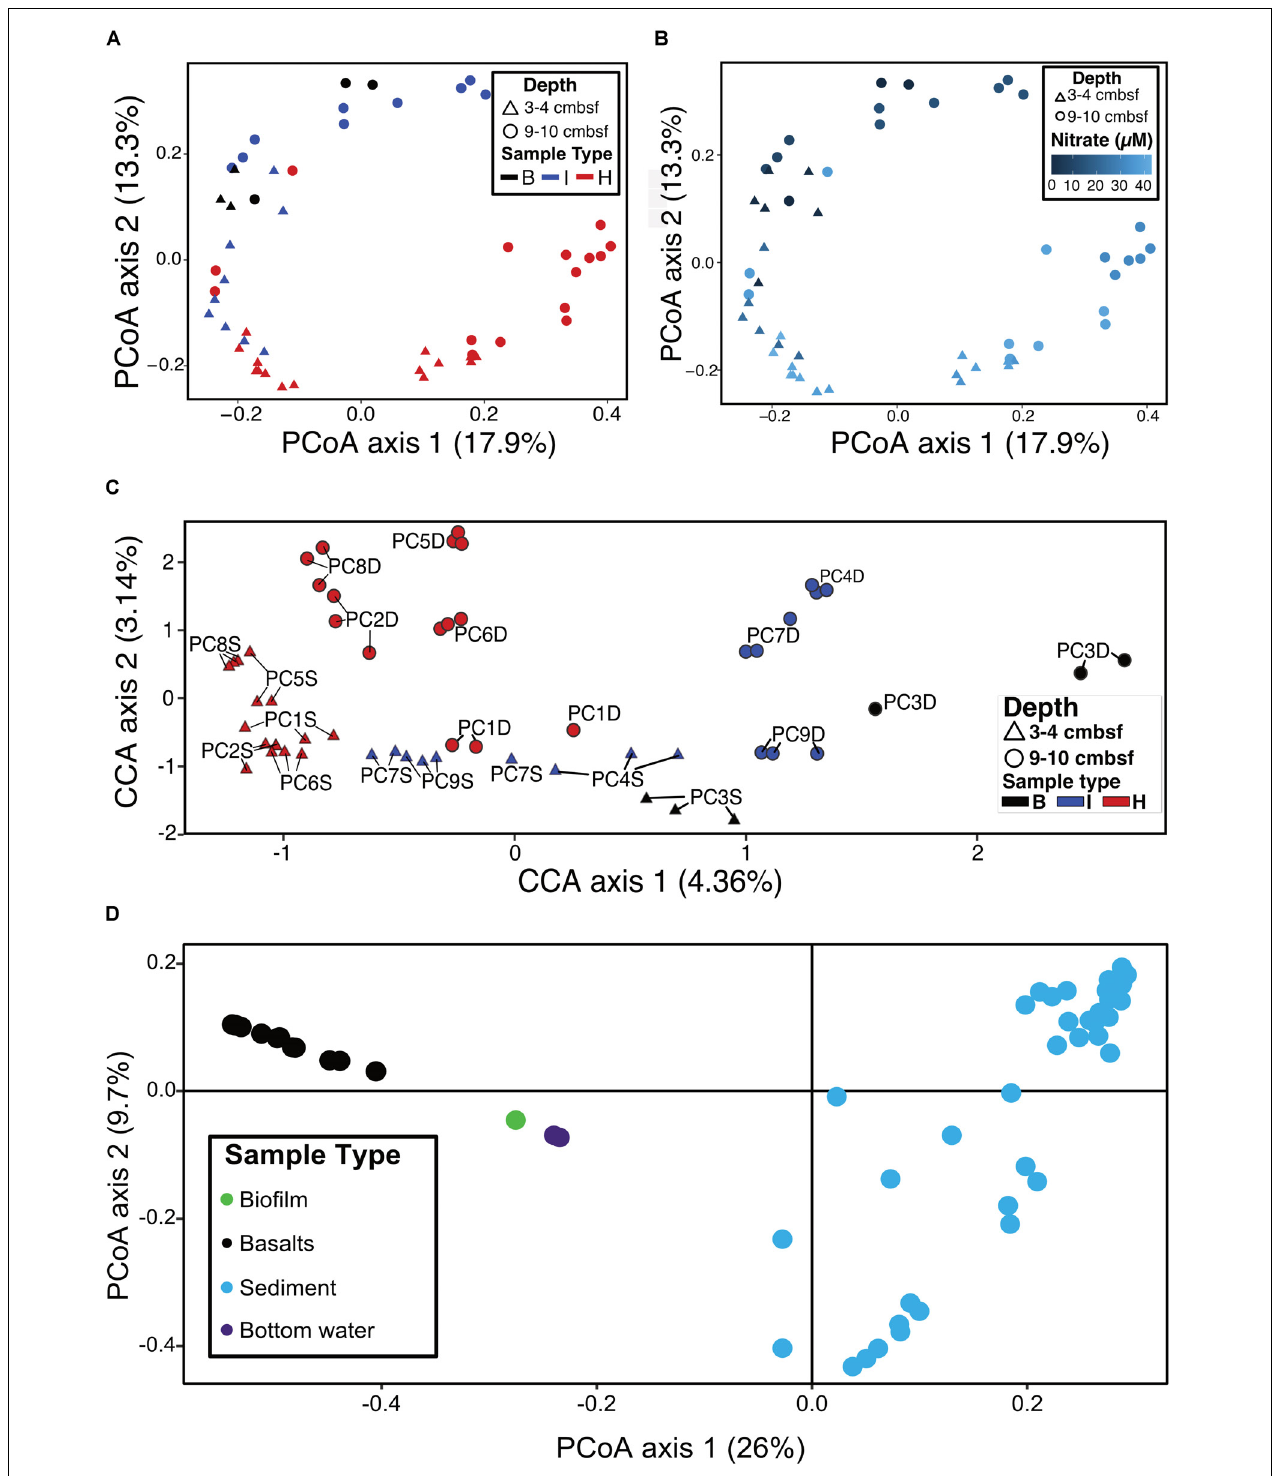
FIGURE 6 | (A) Principal coordinates analysis (PCoA) of log transformed ASV abundance data showing clustering of samples by similarity using the Bray–Curtis dissimilarity index based on rank abundance, with points (samples) colored by sample type. (B) PCoA as in (A) , with color coded by nitrate concentration. (C) Canonical correspondence analysis (CCA) of samples based on Bray–Curtis dissimilarity index using log-transformed ASV frequencies, nitrate concentrations, and solid phase manganese concentrations. Labels show the core number (PC#), D indicates a deep sample (9–10 cmbsf) and S indicates a shallow sample (3–4 cmbsf). (D) PCoA of sediments (this study) and basalts, basaltic biofilm, and seawater samples (Lee et al., 2015).